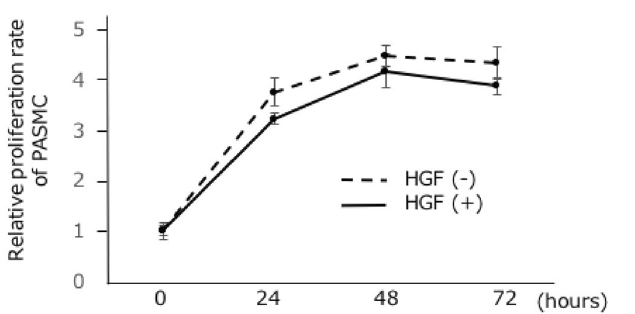
Figure 2. Proliferation assay of pulmonary smooth muscle cells (PASMC) after treatment with hepatocyte growth factor (HGF). HGF treatment (10 ng/mL) significantly suppressed the proliferation of PASMCs at 24, 48, and 72 h, respectively. n = 5. * P <